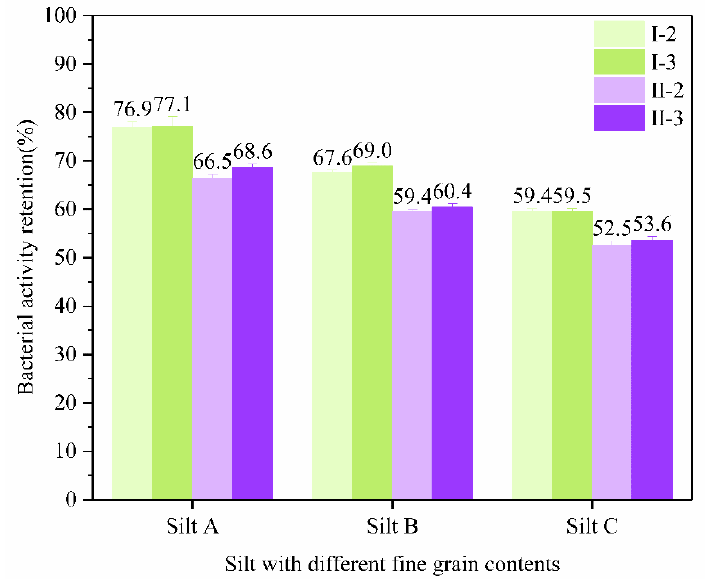
Figure 9. Effect of different fine particle content on the ability to retain bacteria.